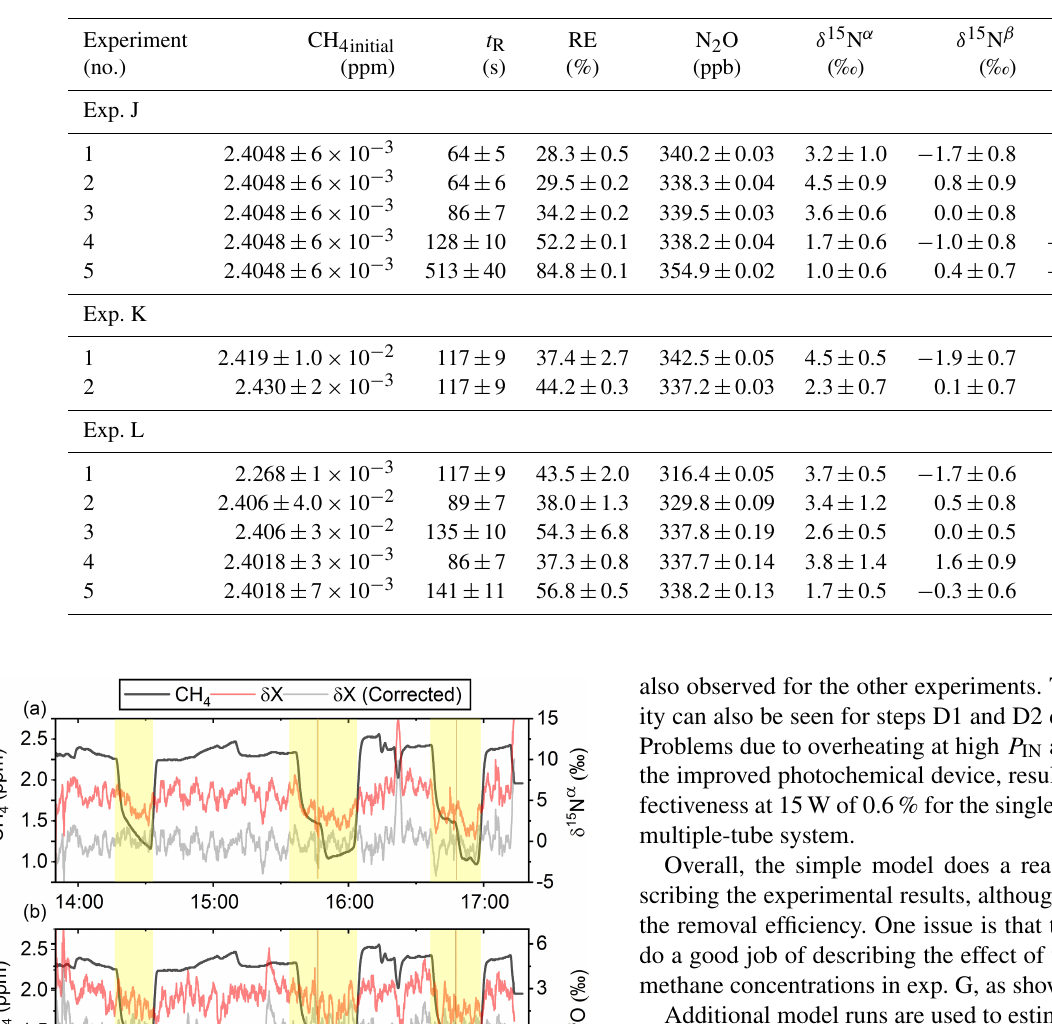
Table 4. Experimental data for the N 2 O experiments using the G5131-i for N 2 O analysis. Columns: experimental steps, initial [CH 4 ] (ppm), residence time in seconds, removal efficiency in percent (%), [N 2 O] (ppb), δ 15 N α , δ 15 N β and δ 18 O (‰) refer to the three isotopologue measurements of N 2 O. Each of the three isotope values have been corrected for the effects of oxygen, CO and N 2 O variation according to the method described in Harris et al. (2020). The values have not been bound to an absolute scale by the use of calibration gas, so the daily isotope levels unaffected by methane are shown in the day.